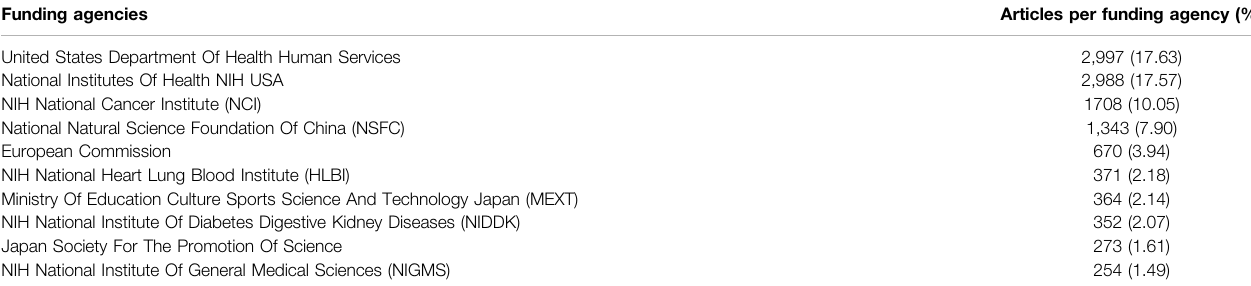
TABLE 6 | Top 10 active funding agencies for published research related to CMF and in fl ammation for 1990 –